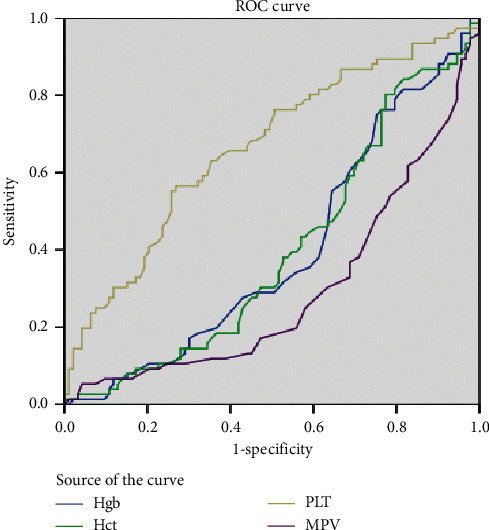
ROC curves for hemoglobin, hematocrit, platelet and main platelet volume. AUCHgb = 0,398; AUCHct = 0,399; AUCPC = 0,664; AUCMPV: 0,293. Hgb: Hemoglobin; Hct: Hematocrit; PC: Platelet count; MPV: Main platelet volume.